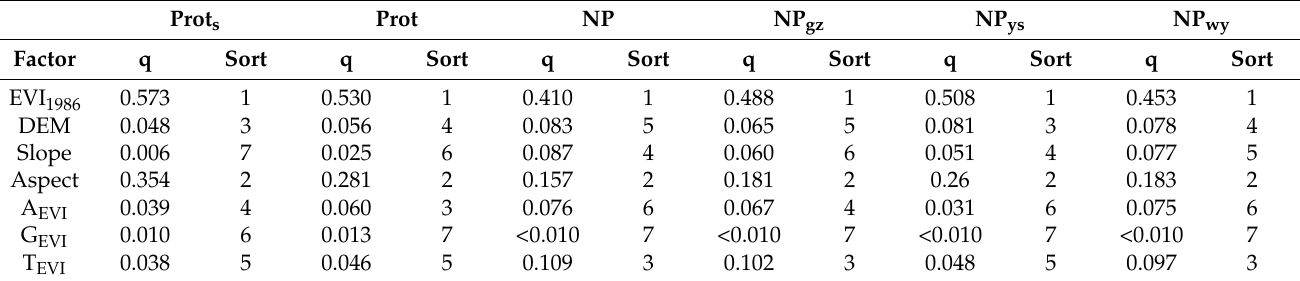
Table 7. Factor detection in Wuyishan National Park during